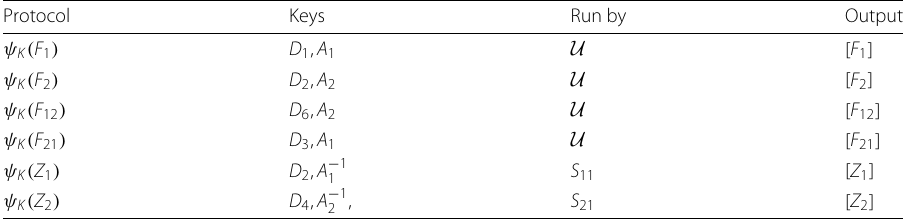
Table 2 Matrix transformation protocol run per